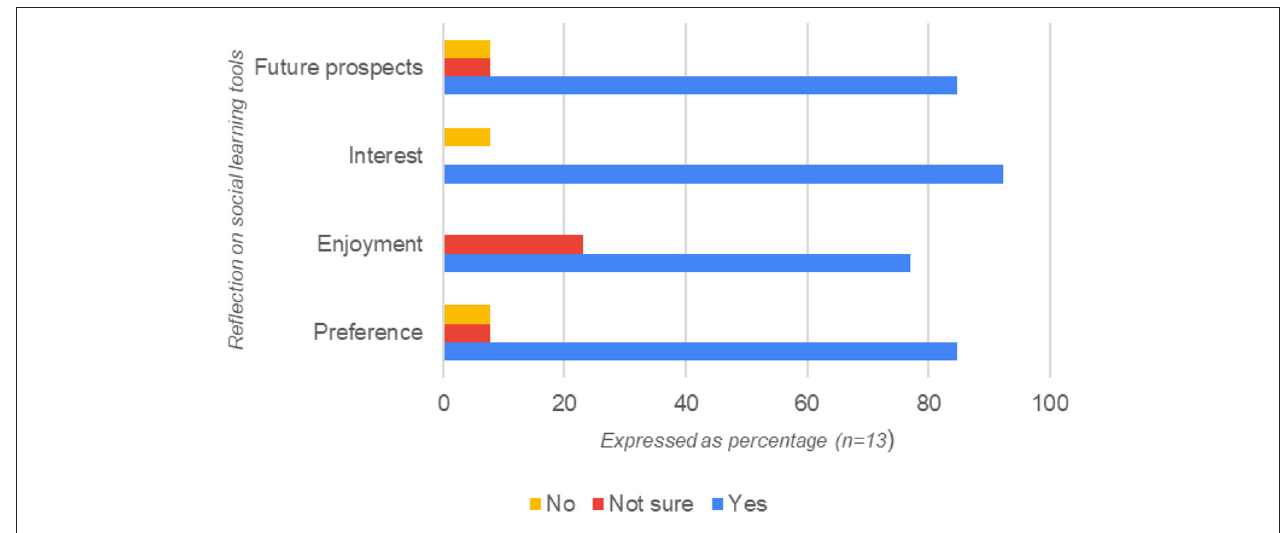
FIGURE 5 | Preference pertaining to social learning tools.